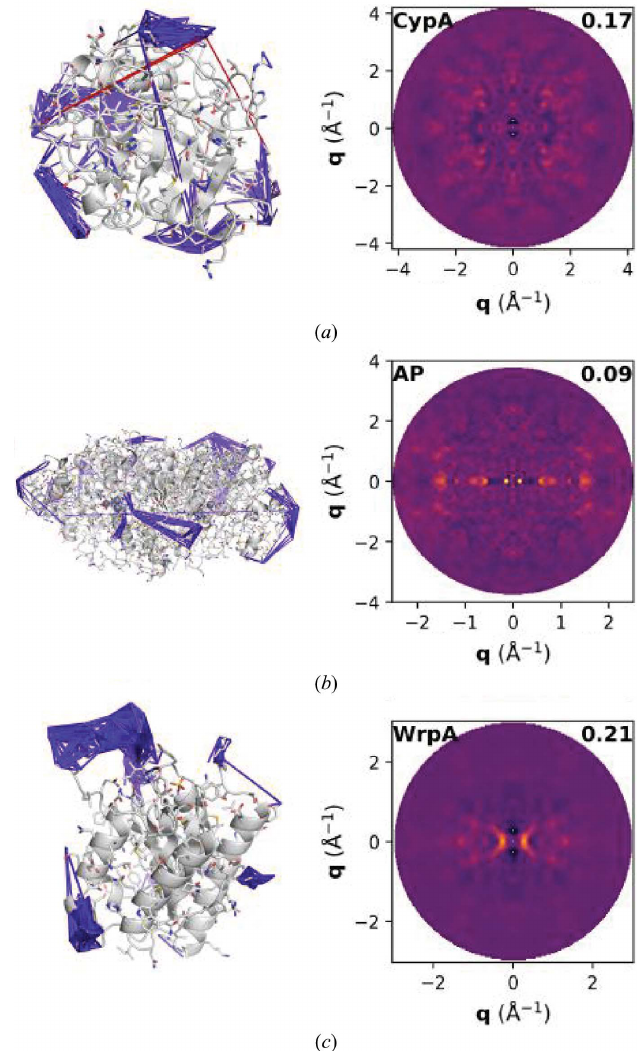
Figure 2 Elastic network models of Gaussian disorder. The highest and lowest magnitude entries in the covariance matrix are overlaid as blue and red cylinders, respectively, on the refined atomic coordinates for ( a ) CypA, ( b ) AP and ( c ) WrpA. The 0 kl slices of the predicted diffuse scattering maps are shown on the right, with the overall CC noted in black. The color scales differ from Fig. 1 to enhance visualization of the